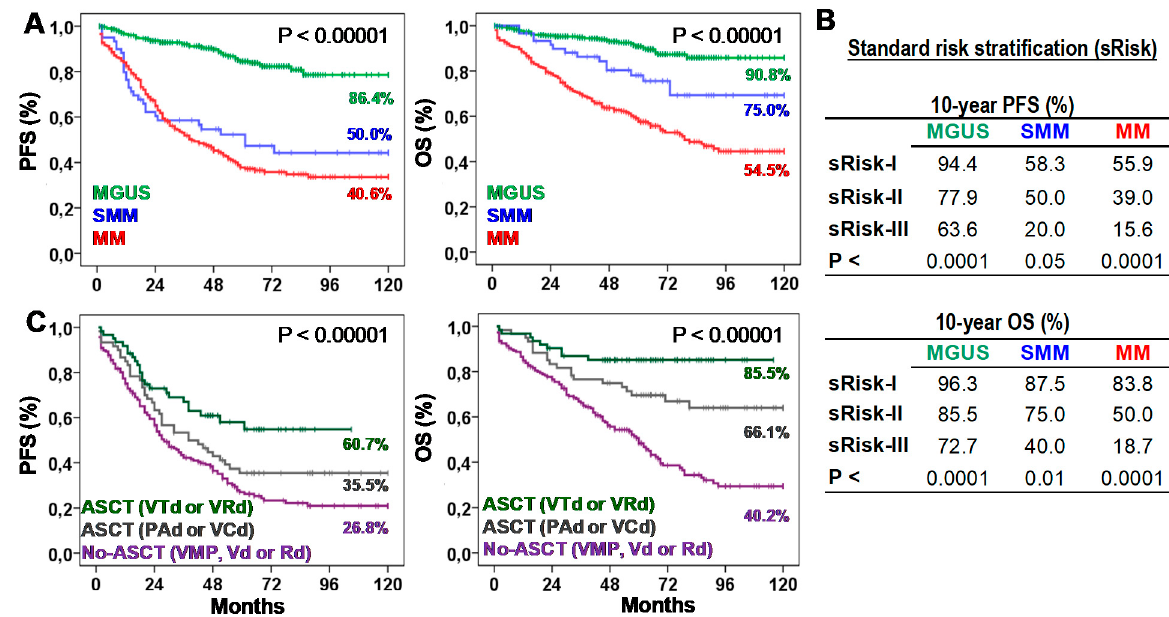
Figure 1. Survival of patients according to the type of plasma cell neoplasm (PCN), their standard risk or the type of first-line treatment. ( A ) Kaplan-Meier and Log-rank tests for Progression-Free (PFS) and Overall Survival (OS) according to the type of PCN: monoclonal gammopathy of undetermined significance (MGUS), smoldering multiple myeloma (SMM), or multiple myeloma (MM). Ten-year survivals are shown for each PCN type. ( B ) Ten-year PFS and OS rates (estimated with Kaplan-Meier and Log-rank tests) according to the standard risk (sRisk) for MGUS [30], SMM [7], and MM [8] patients: low (sRisk-I), intermediate (sRisk-II), and high (sRisk-III). ( C ) Kaplan-Meier and Log-rank tests for PFS and OS according to the type of first-line treatment: No-autologous stem cell transplantation (ASCT) with VMP, Vd or Rd; ASCT with PAD or VCD; or ASCT with VTd or VRd. Ten-year survivals are shown for each treatment.